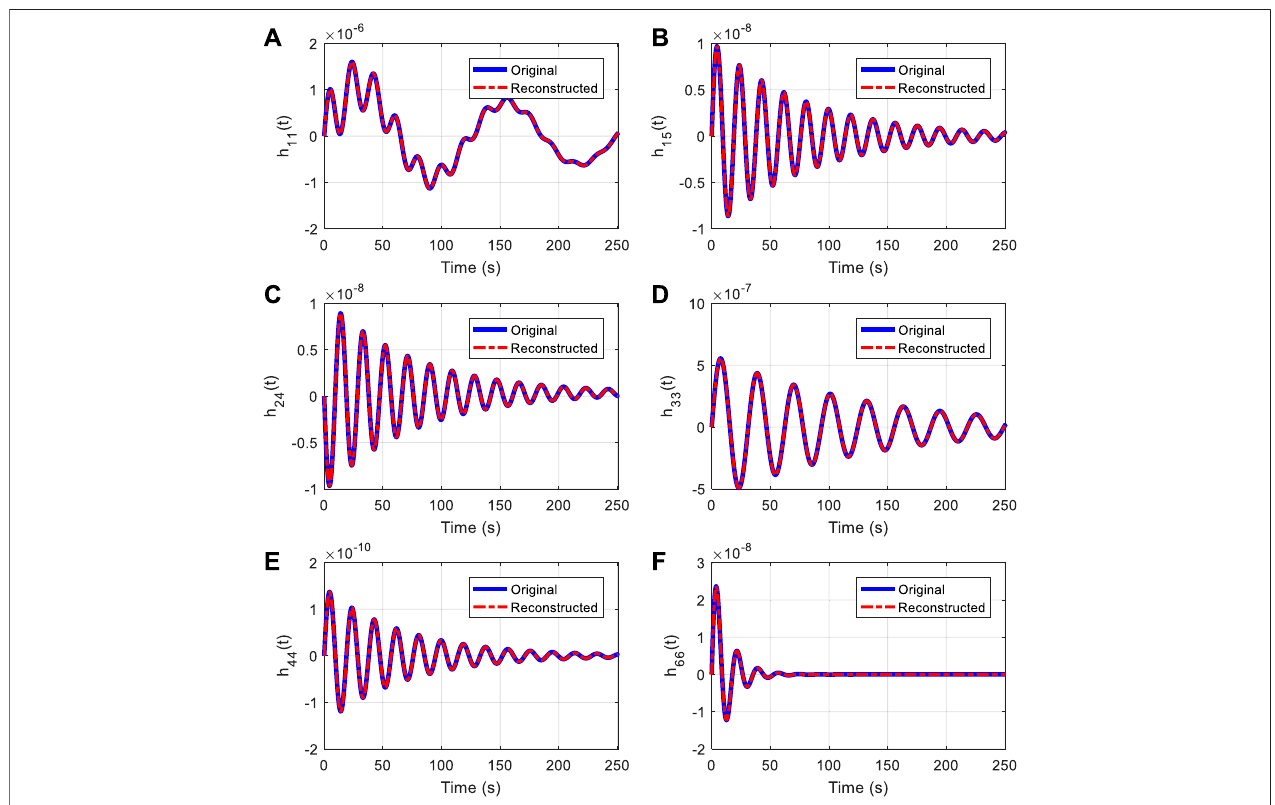
FIGURE 4 | Comparison of the original and reconstructed IRF. (A) h11(t); (B) h15 (t); (C) h24(t); (D) h33(t); (E) h44(t) and (F) h66(t).